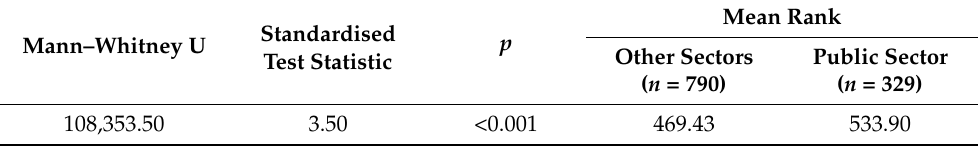
Table 8. Effect of the activity sector in the evaluation of the public service in the citizen shop.